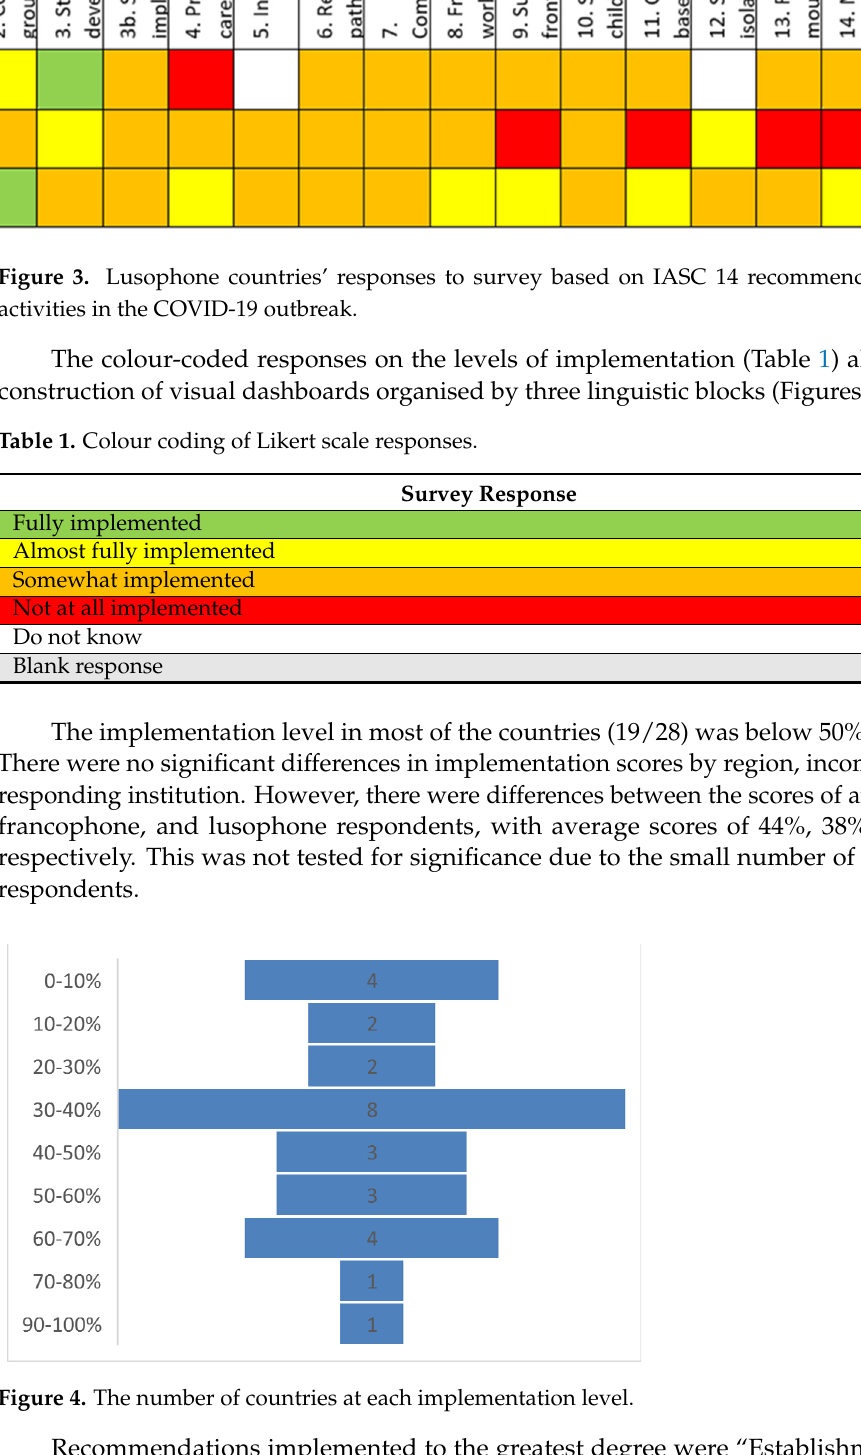
Figure 2. Francophone countries’ responses to survey based on IASC 14 recommended MHPSS ac- tivities in the COVID-19 outbreak.